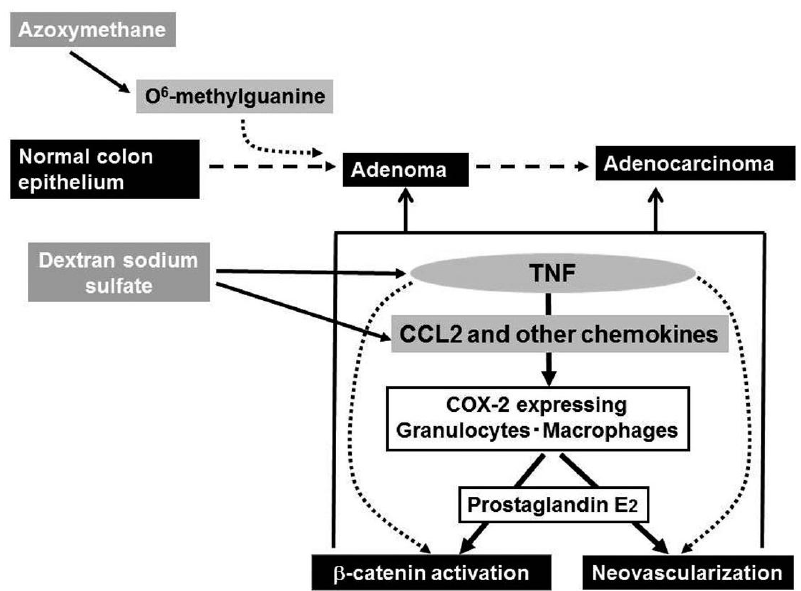
Figure 4. Presumed roles of TNF-  and CCL2 in AOM/DSS-induced colon